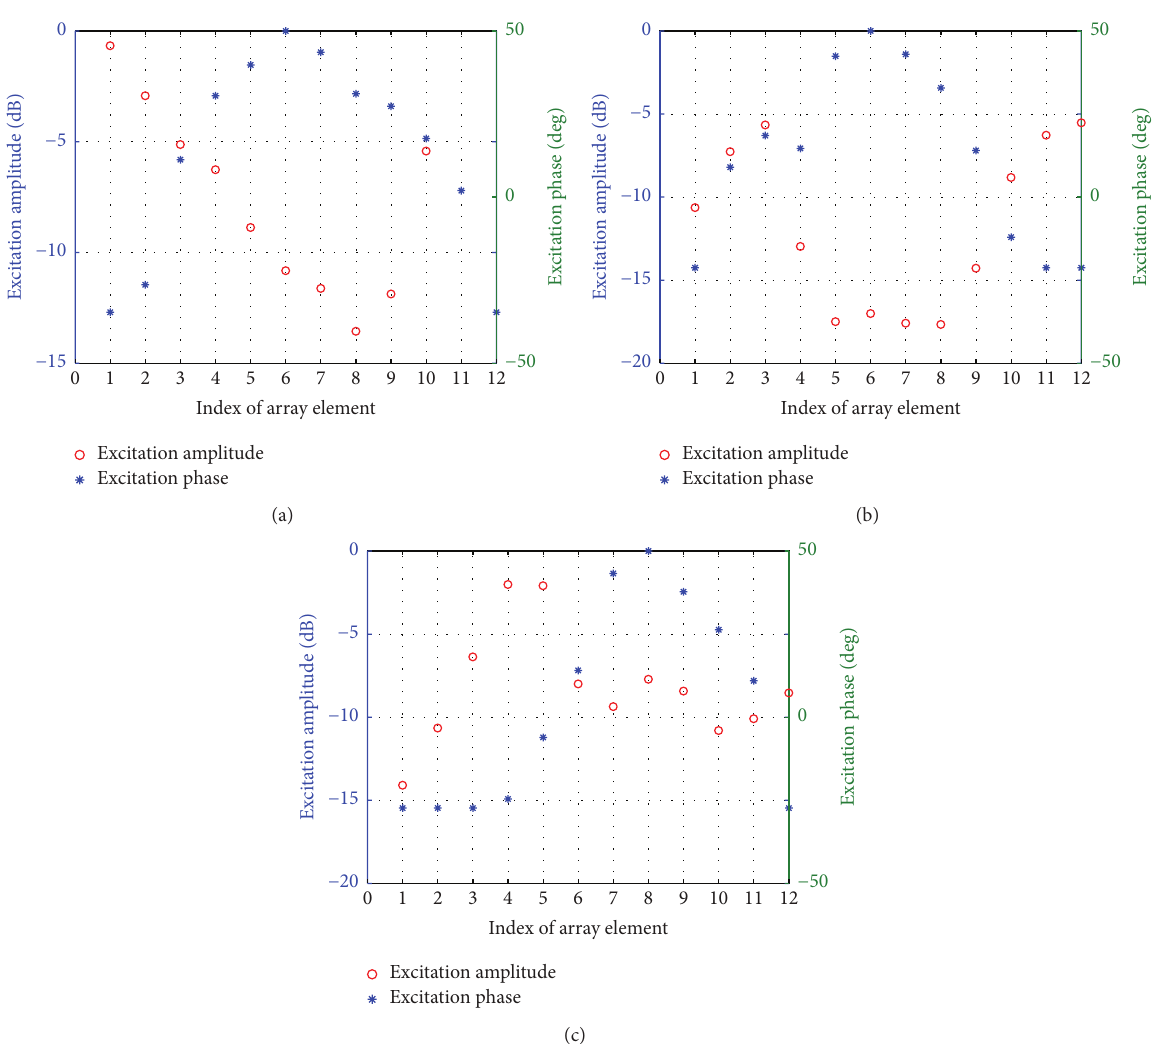
Figure 4: Excitation distributions of CSP synthesis. (a) AAP method, (b) WARP method, and (c) proposed